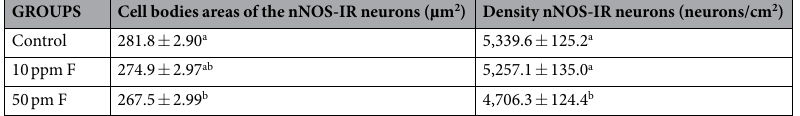
Table 3. Means and standard errors of the values of the cell bodies areas and density of the nNOS-IR myenteric neurons of the duodenum of rats exposed or not to F chronically, through the drinking water for 30 days. Animal groups: Control (deionized water–0 ppm F), 10 ppm F, and 50 ppm de F. In the quantitative analysis the Fisher’s test was applied but no significant difference was observed among the groups. In the morphometric analysis, means followed by different letters in the same column are statistically different according to Tukey’s test (p < 0.05).